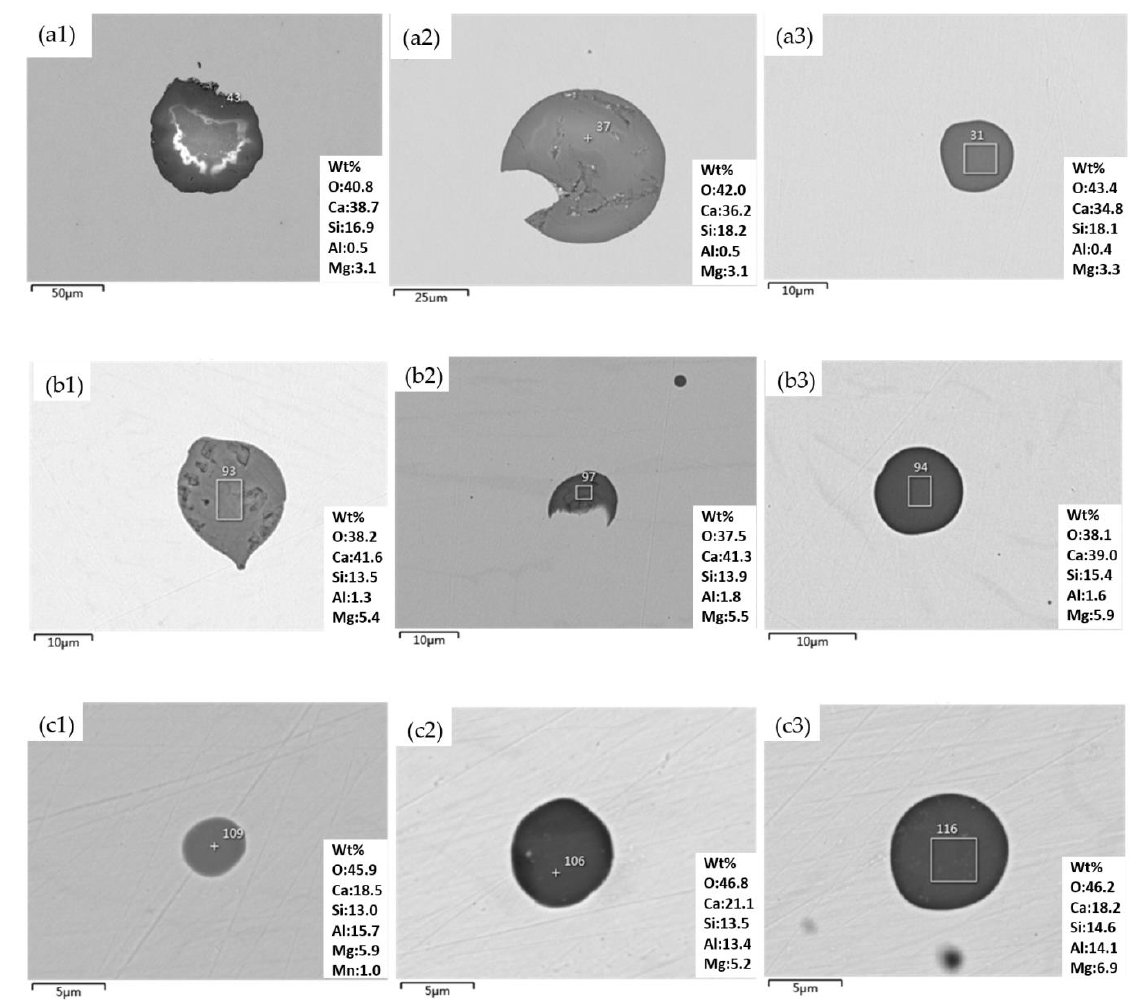
Figure 1. Morphology and composition of typical inclusions in samples: ( a ) typical inclusions at the end of AOD; ( b ) typical inclusions at the end of LF refining; ( c ) typical inclusions in the tundish.